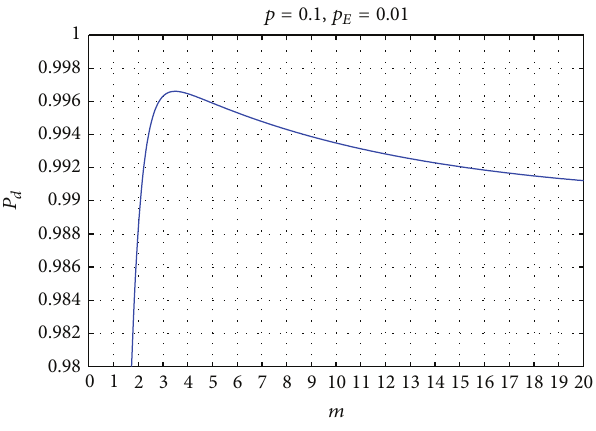
Figure 4: The relationship between 𝑃 𝑑 with 𝑚 .